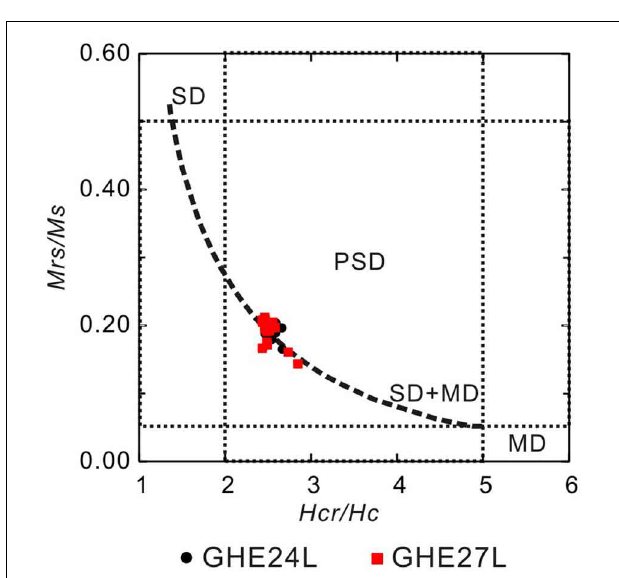
FIGURE 5 | Thermomagnetic properties of Cores GHE24L (A,B) and GHE27L (C,D) sediments suggest that magnetite is the main magnetic phase in the sediments. (A–D) Show similar irreversible